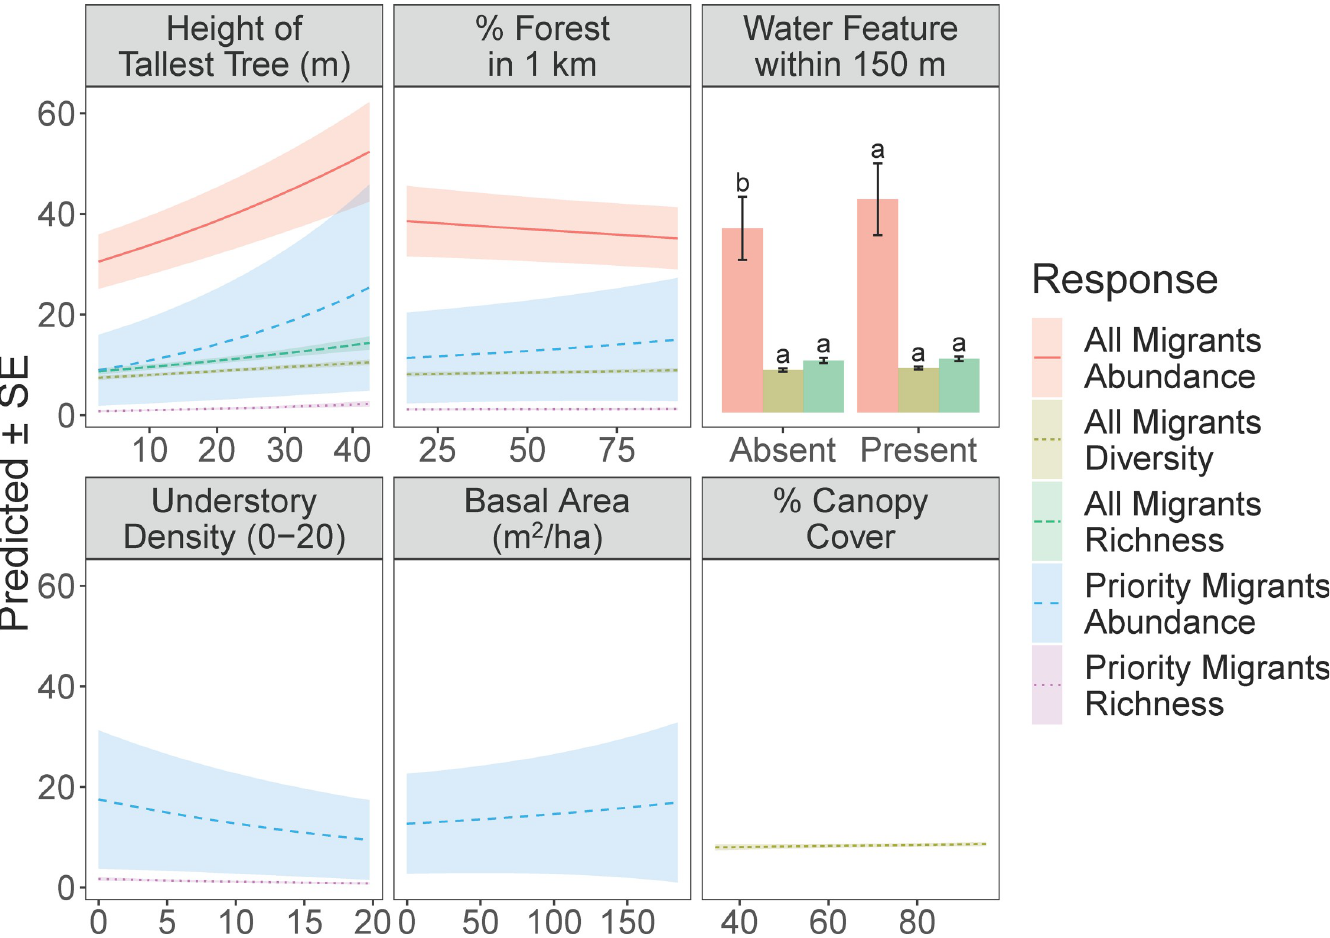
Fig 4. Model averaged predictions for five avian response categories to six habitat and landscape level variables across 5 cover types in eastern Guatemala during winter 2015–2016 and winter 2016–2017. Letters indicate significant differences among cover types at p � 0.05.